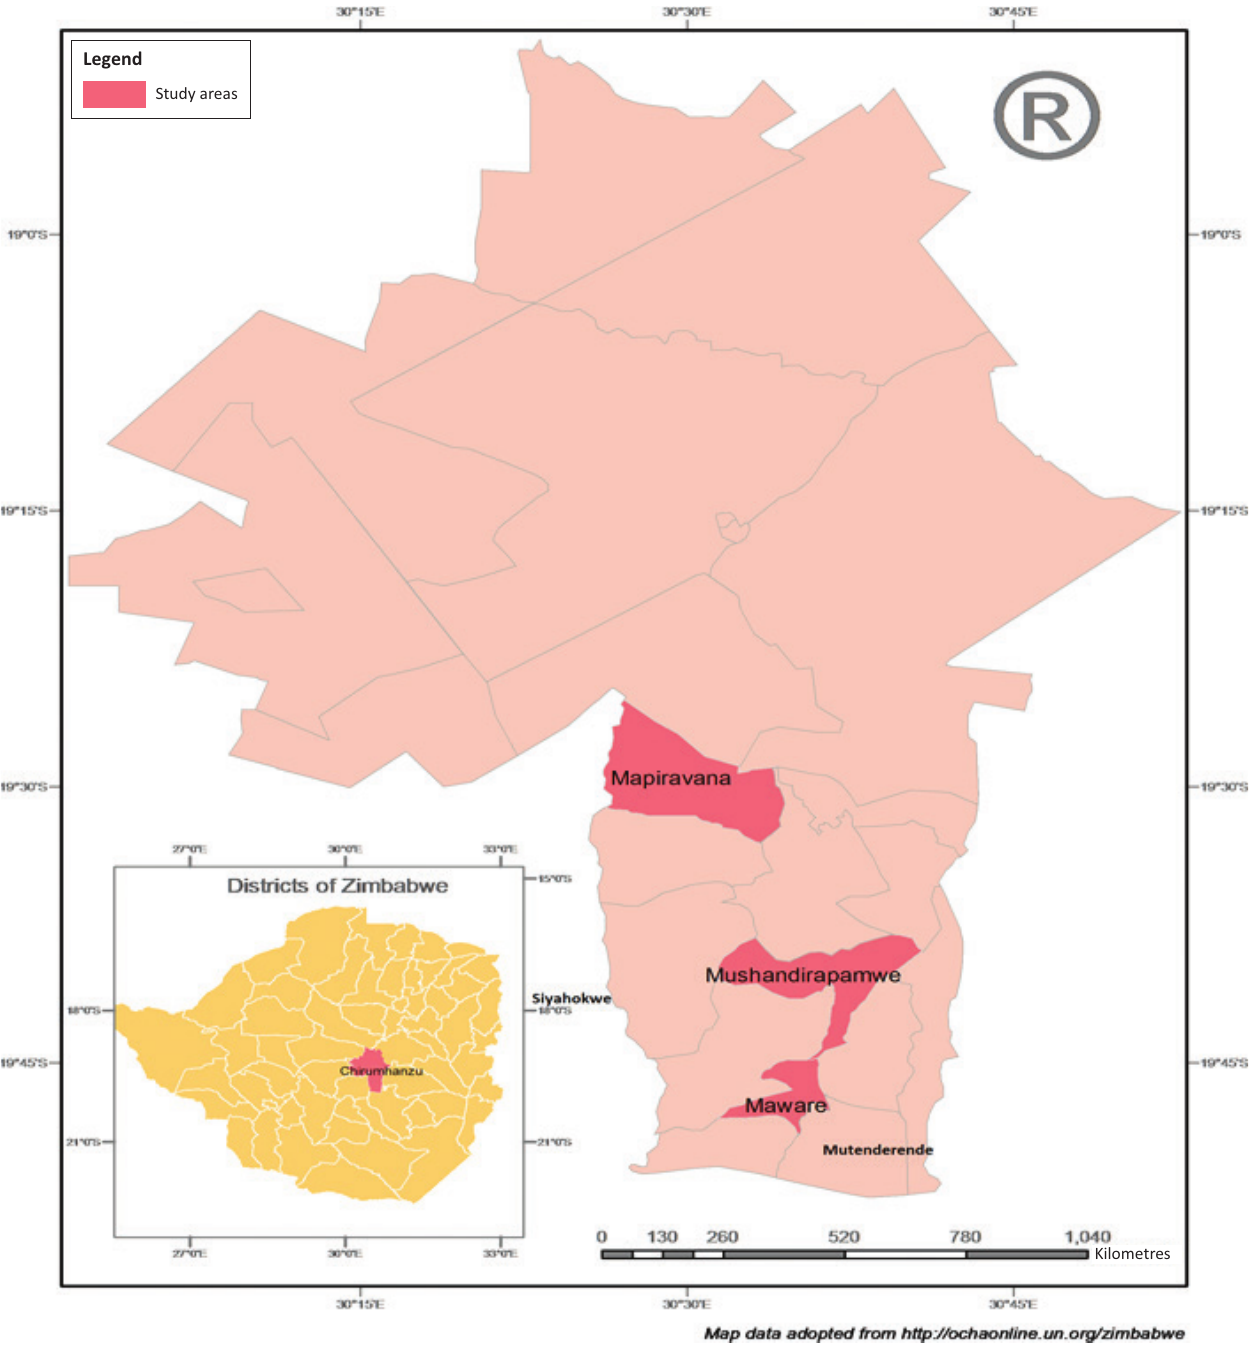
FIGURE 1: Map of the study